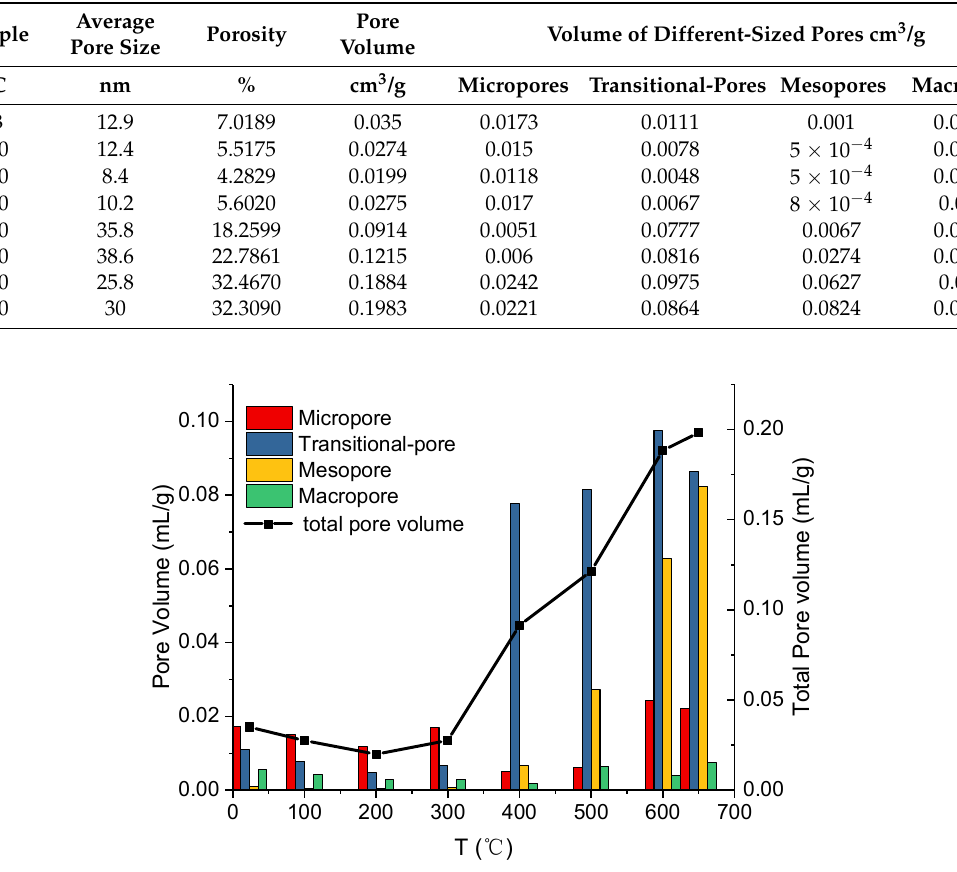
Table 3. Main pore structure parameters of MIP.